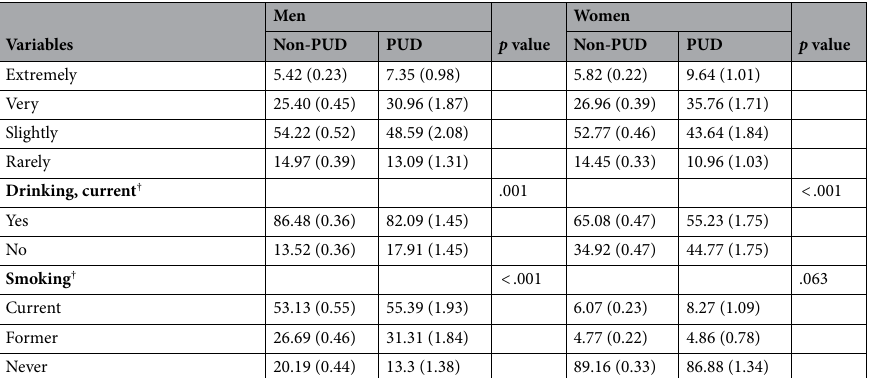
Table 1. General characteristics of the subjects in this study. BMI body mass index, SBP systolic blood pressure, DBP diastolic blood pressure. *: p < 0.05; **: p < 0.01; † p < 0.001. *, ** and † indicate p values for the sex difference. Continuous variables are summarized as the means ± SE (standard error). Categorical variables are summarized as percentages (SE). p values were obtained from a general linear model for continuous variables and from Rao-Scott chi-squared tests for categorical variables between the group without PUD and the group with PUD. All statistical analyses were performed using weight parameters, cluster parameters and stratification parameters to account for the complex sampling